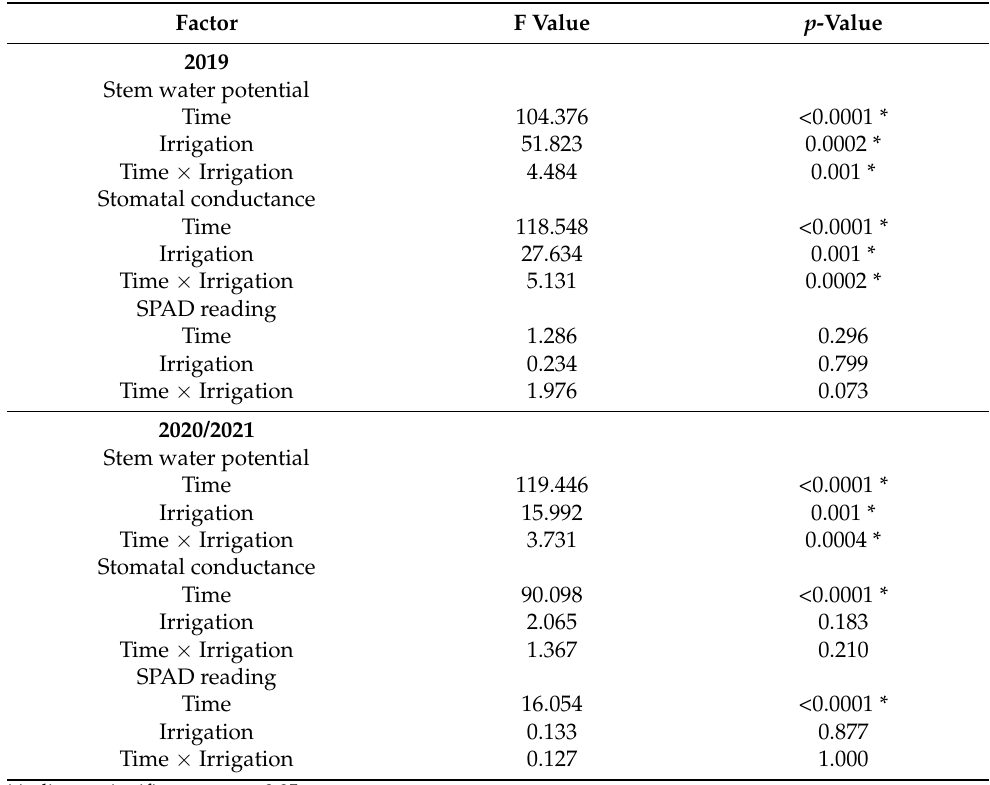
Table 5. Repeated measures ANOVA applied to stem water potential, stomatal conductance and SPAD reading in relation to time, irrigation (treatment) and their interactions.